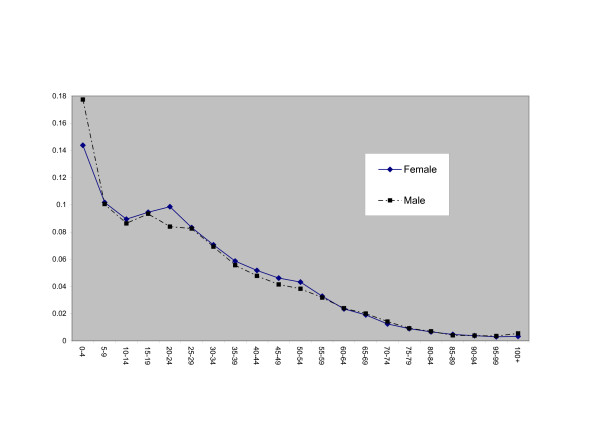
Age Weights, Model 2.